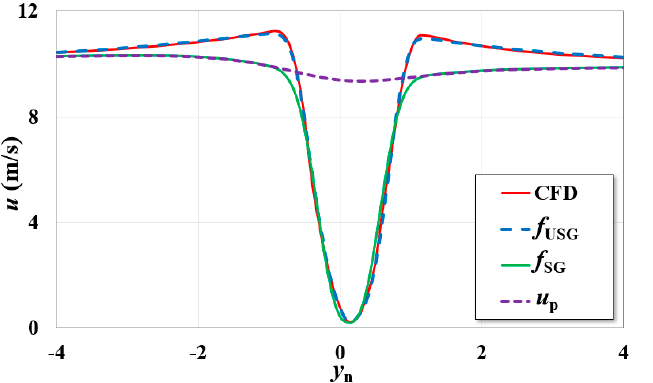
Figure A1. Comparison of the profiles of the x -component velocity of the wake of an isolated rotor at x n = 2.0 (reproduced with permission from Buranarote et al. [37]).